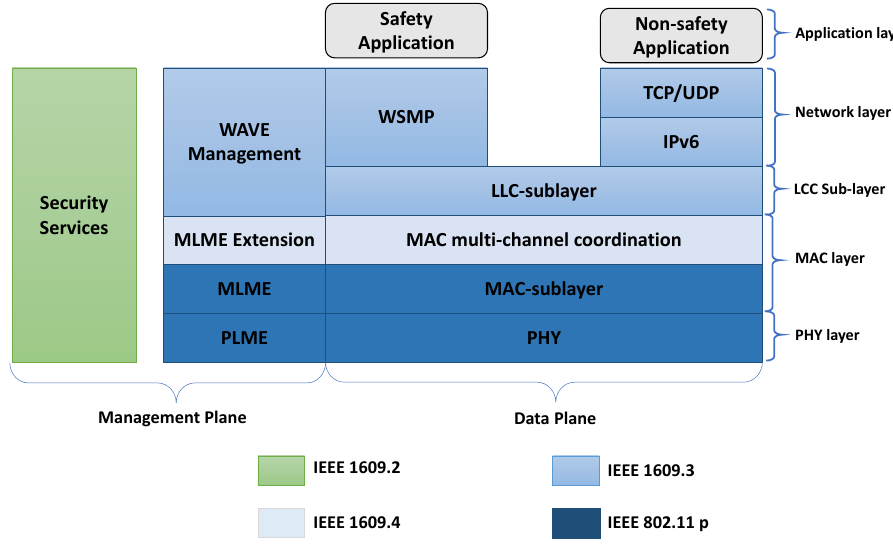
Figure 3. WAVE protocol stack showing management plane and data